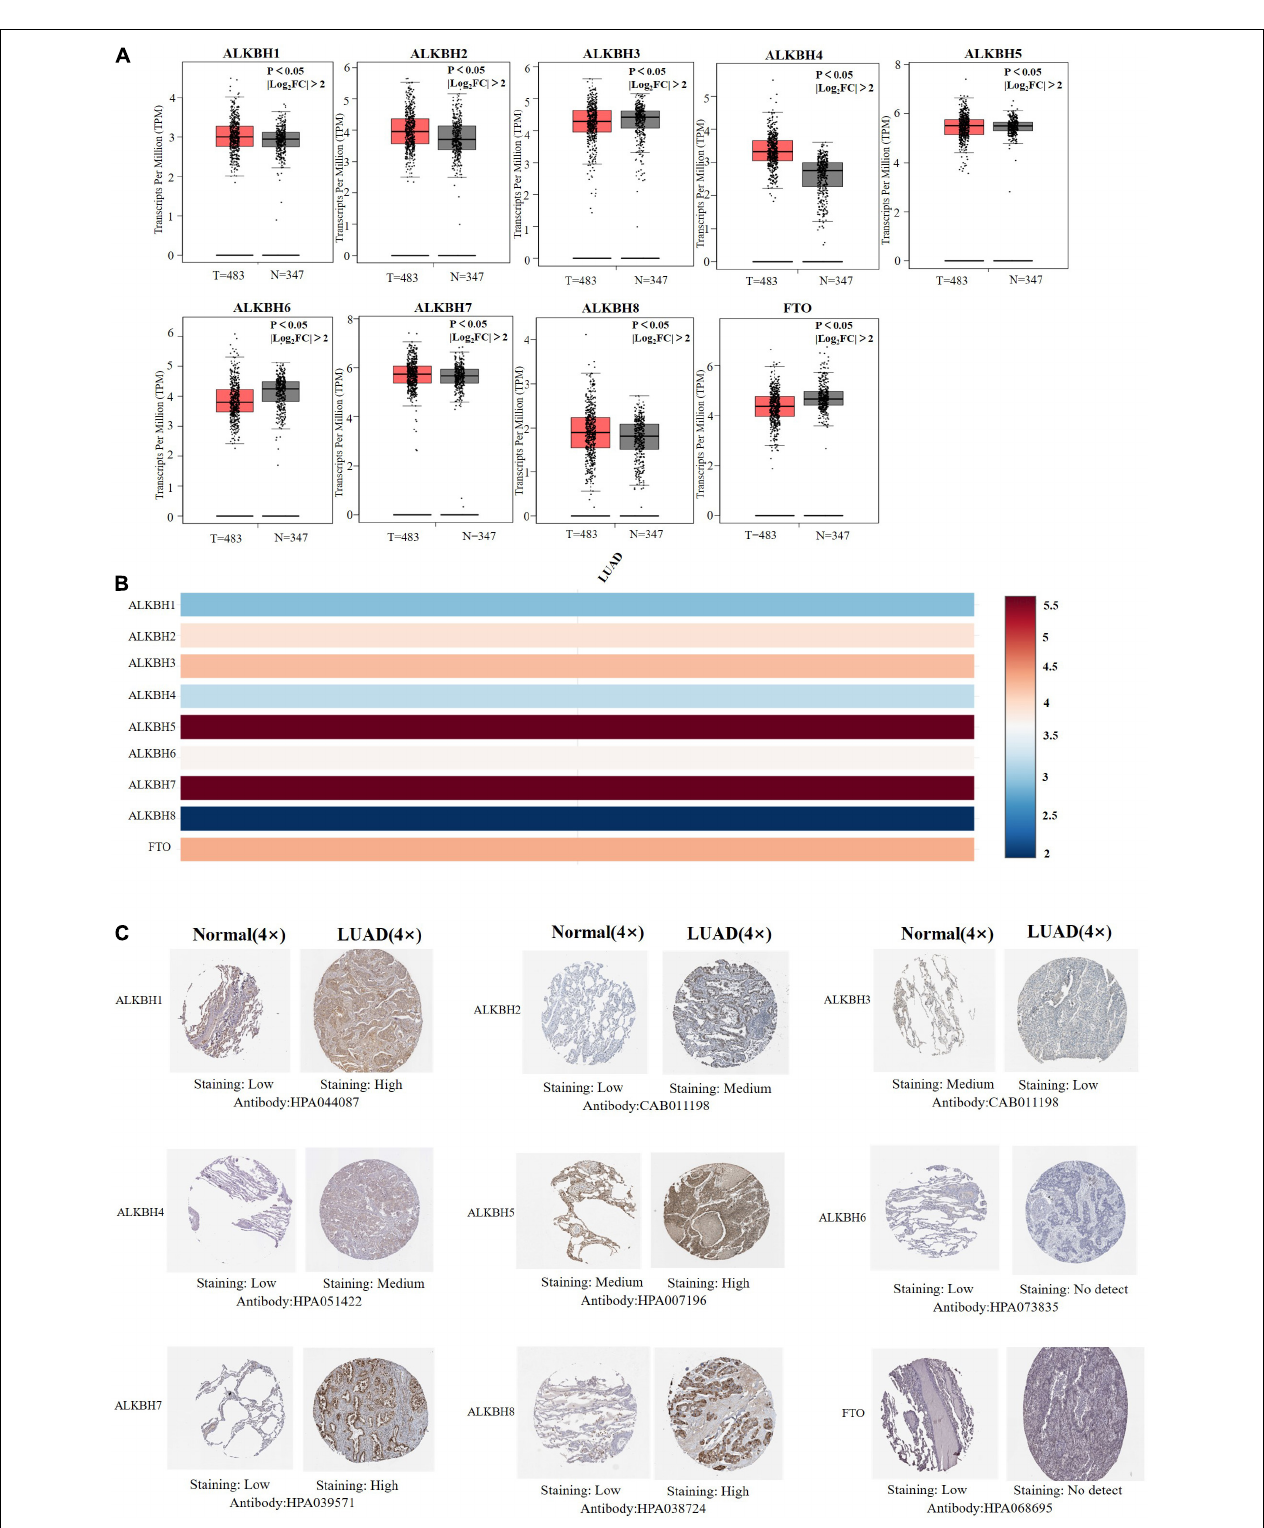
FIGURE 1 | (A) mRNA expression levels of different AlkB family members in LUAD and normal lung samples (GEPIA). T and N indicated the LUAD tissues and normal tissues, respectively. (B) The relative expression of the AlkB family in LUAD. (C) Immunohistochemical expression of ALKB family in LUAD tissue and normal lung tissue (the Human Protein